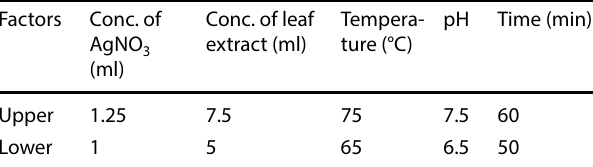
Table 1 Levels of factors considered in the factorial experimental design for green synthesis Conc. of leaf Factors Conc. of extract AgNO 3 (ml)